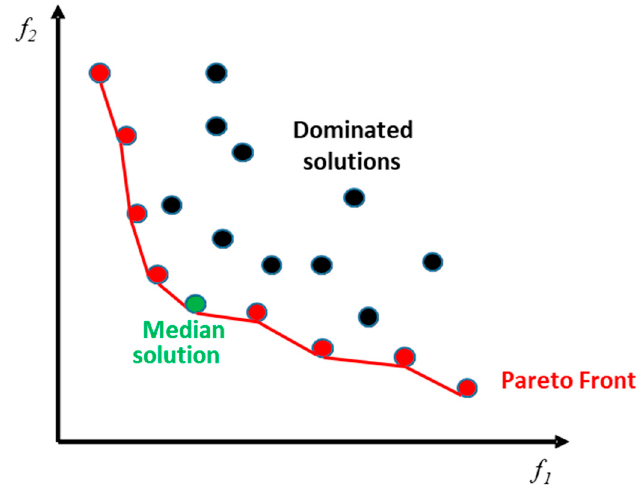
Figure 4. Illustration of Pareto front solutions.